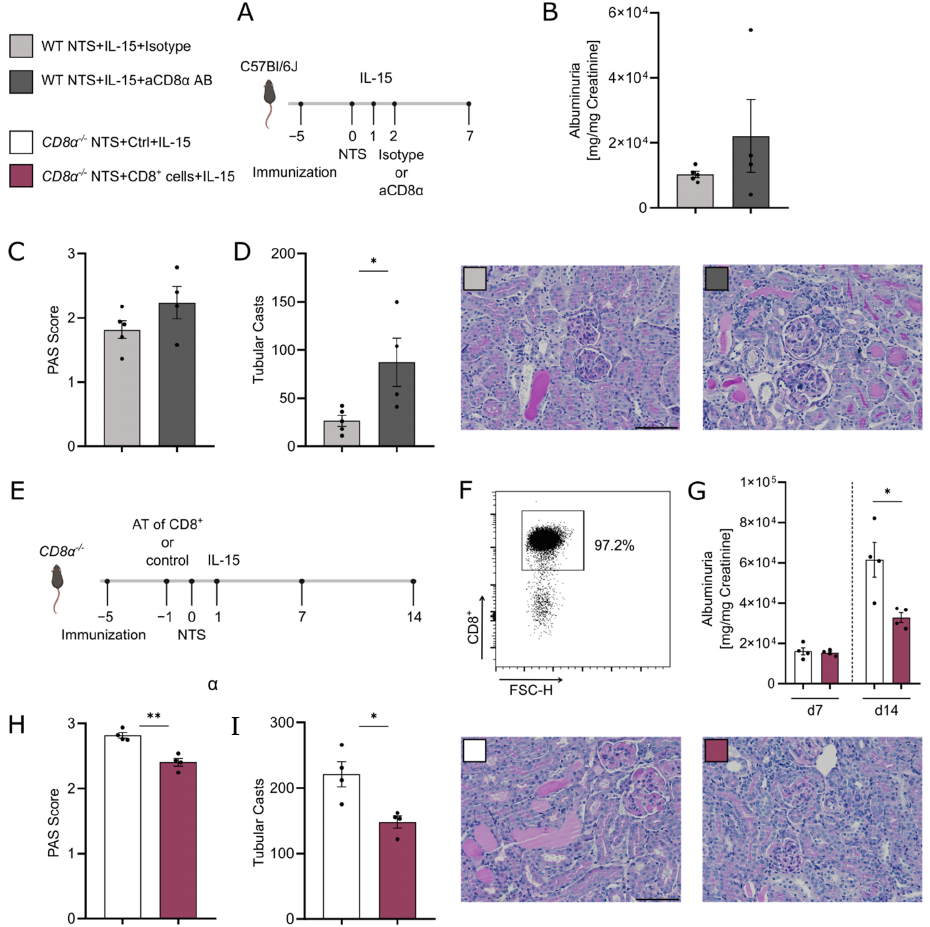
Figure 6. Adoptive transfer of CD8 α + cells into knockout mice and rIL-15 treatment reveal belated amelioration of NTS. ( A ) Timeline of the experimental setup of 7 days of NTS with low-dose rIL-15 intervention in both groups plus aCD8 α antibody or isotype control antibody. ( B ) Urinary albumin to creatinine ratio, ( C ) PAS Score, and ( D ) tubular cast formation per 12 hpf in both groups and representative histological PAS stainings (×20 magnification, scale bar bottom right 100 µm). ( E ) Timeline of the experimental setup of 14 days of NTS in CD8 α − / − mice. One group received 2.5 × 10 6 CD8 α + cells on day –1, and both groups were treated with low-dose rIL-15 on day 1 of NTS. ( F ) Dot plot of sorted and adoptively transferred CD8 α + cells showing 97.2% purity of cells. ( G ) Urinary albumin to creatinine ratio on days 7 and 14 of NTS, ( H ) PAS Score, and ( I ) tubular cast formation per 12hpf on day 14 of NTS and representative histological PAS stainings (×20 magnification, scale bar bottom right 100 µm). * p ≤ 0.05, ** p ≤ 0.01. Statistical analysis used was Student’s t -test or Mann– Whitney test. All data are mean ± SEM.